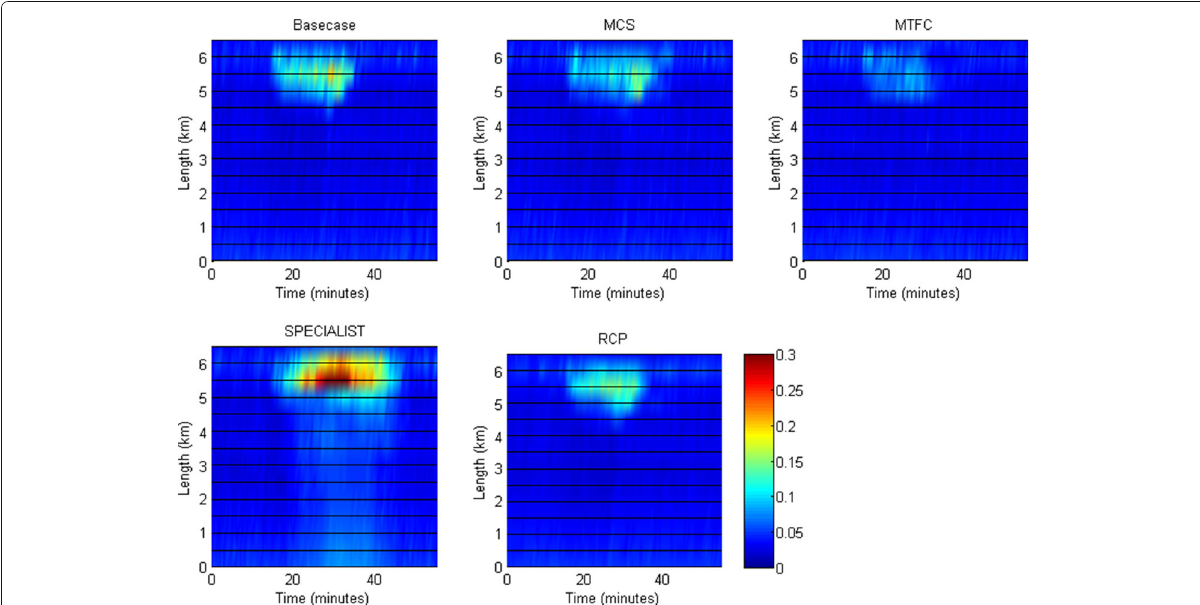
Fig. 5 The Coefficient of Variation of Speed (CVS) for the base case and the VSL algorithms